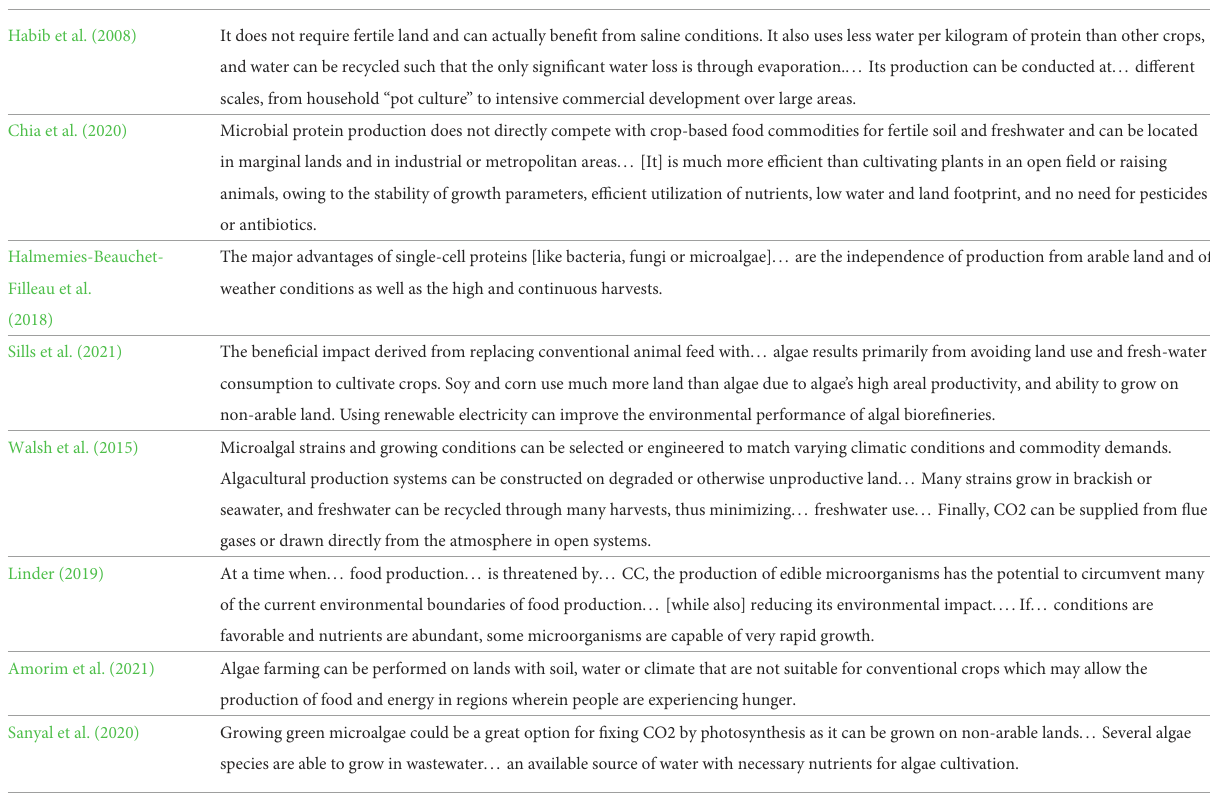
TABLE 2 Characteristics of microalgae production flagged by different